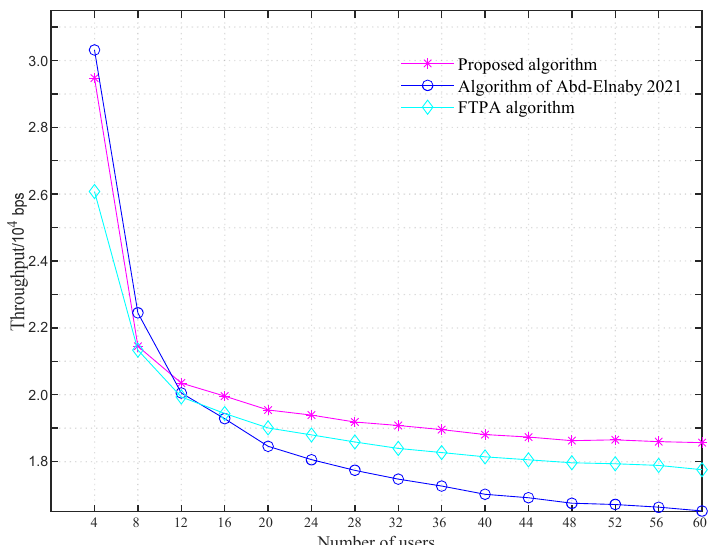
Figure 3. Throughput varies with the number of users.